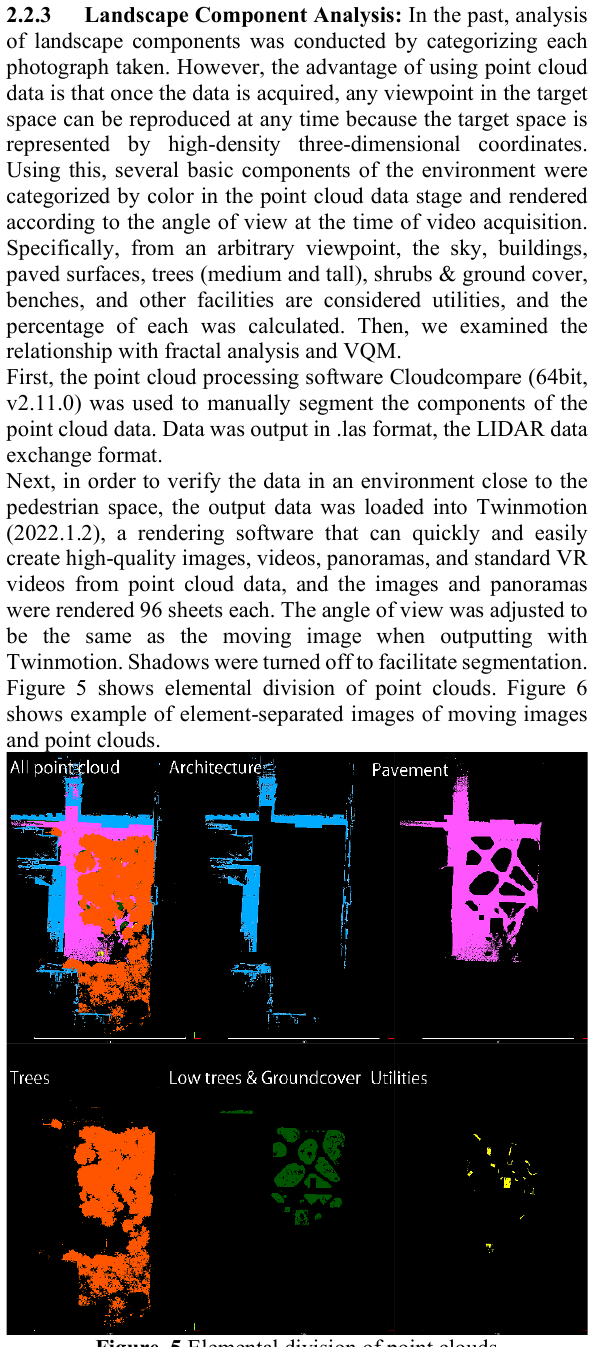
Figure .5 Elemental division of point